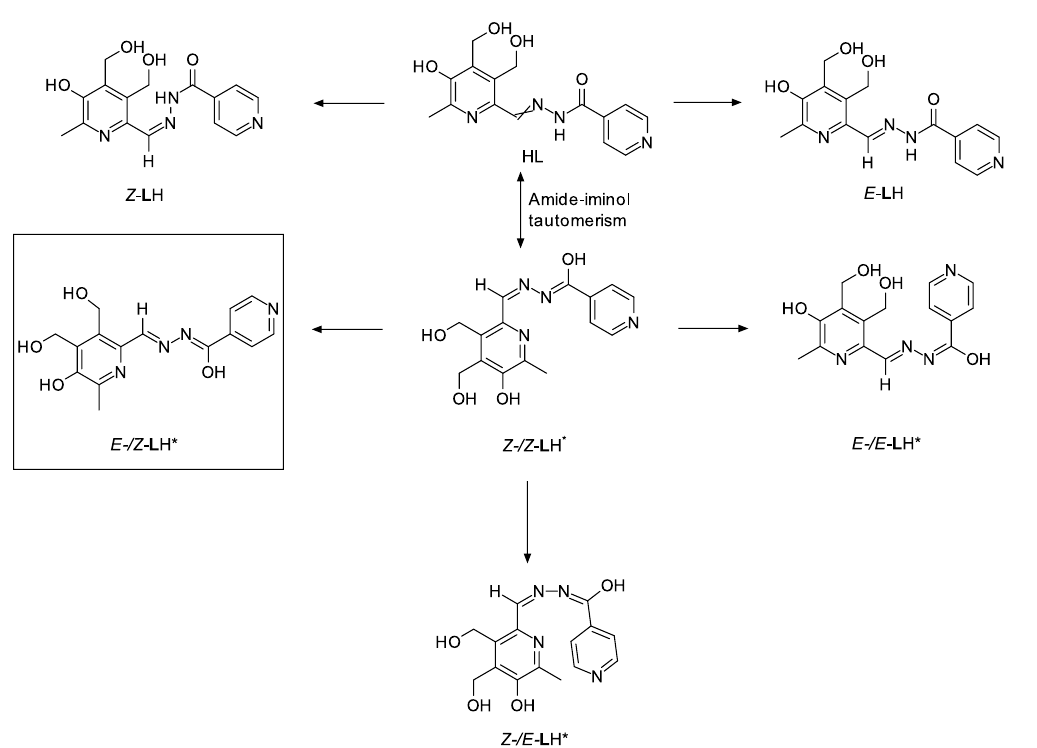
Figure 1. Isomerism of the L H ligand. LH * – ligand conformers designation.